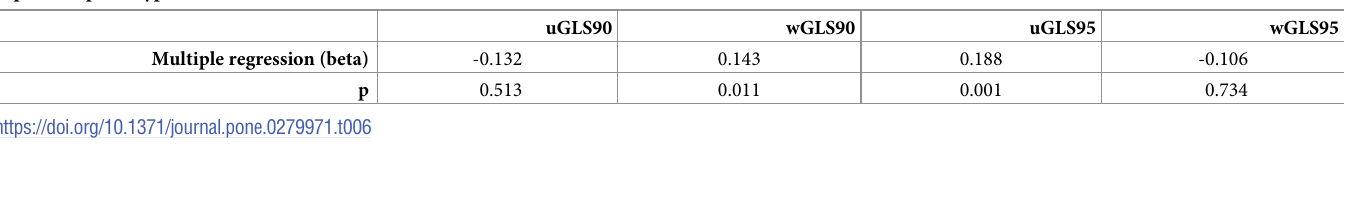
Table 6. The results of a multivariate linear regression analysis including all genetic scores as independent variables and the continuous age-at-death variable as the dependent